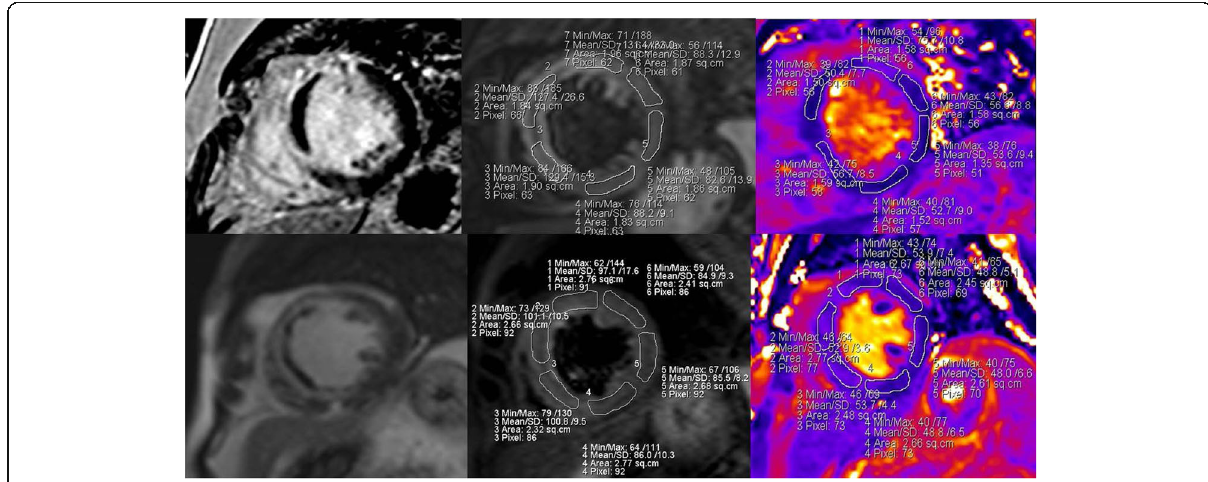
Fig. 2 Late gadolinium enhancement (LGE) short axis views (first column) show transmural infarction along the territorial supply of the culprit artery, and dark core signals representing areas of microvascular obstruction in two different patients. The corresponding turbo inversion magnitude (TIRM) images short axis views (middle column) show myocardial edema as well as hypointense core within. T2 mapping images (third column) show dropped signal (< 60 ms) of the corresponding hypointense cores representing areas of intra myocardial